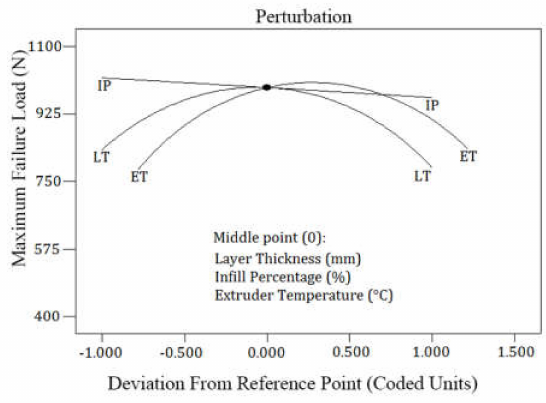
Figure 5. Perturbation plot of the maximum failure load.